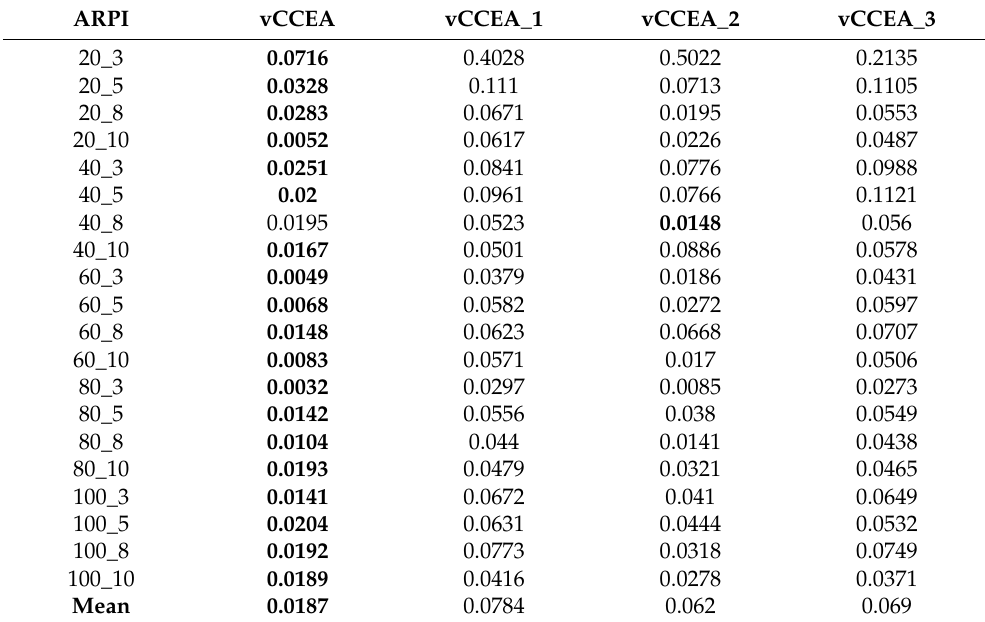
Table 5. Comparison of vCCEA components.